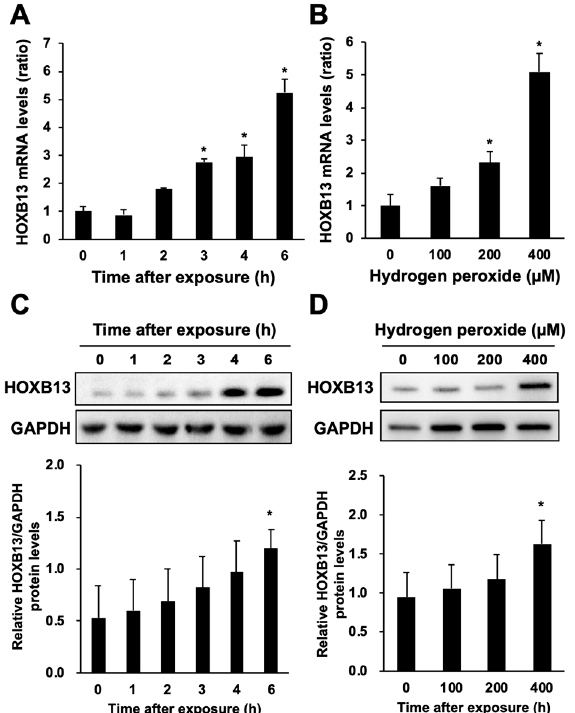
Figure 2. Effects of hydrogen peroxide on HOXB13 expression. A549 cells were seeded onto 6-well plates for 24 h. ( A ) Cells were exposed for the indicated period to hydrogen peroxide (400 µM) or ( B ) exposed to the indicated concentration of hydrogen peroxide for 6 h. The mRNA levels of HOXB13 and GAPDH were measured, and the relative values normalized to GAPDH are shown. ( C , D ) Upper panels indicate immunoblots for HOXB13 and GAPDH proteins under the same conditions as in A , B . Lower panels indicate densitometry analysis of the band intensity in C , D . All values are mean ± S.D. of three individual experiments. * p < 0.05 vs. 0 h or 0 µM.